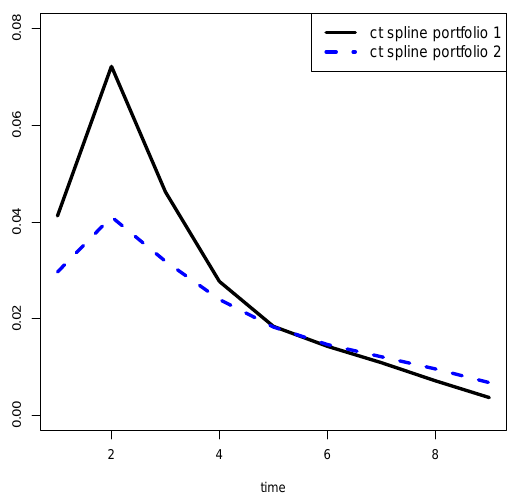
Figure 10. Comparison of recovery curve in term of c t for portfolio 1 and portfolio 2.